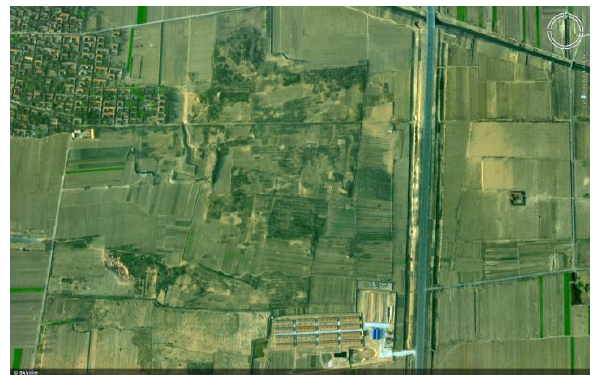
Figure 13. The old course of the Yellow River in Linqing